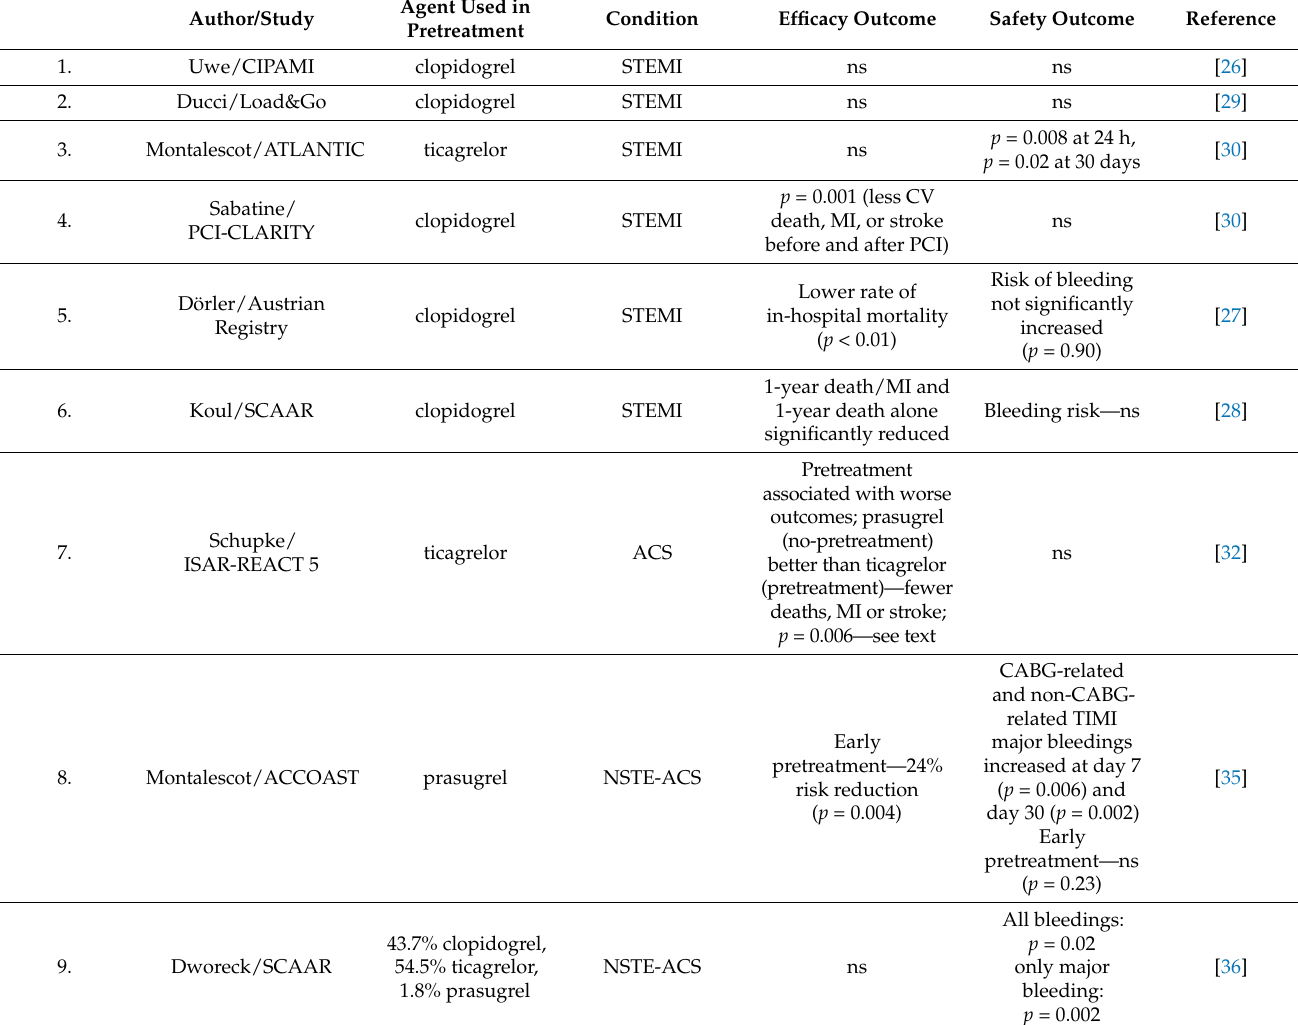
Table 2. A summary of clinical trials and meta-analyses presenting effects of pretreatment with P2Y 12 receptor